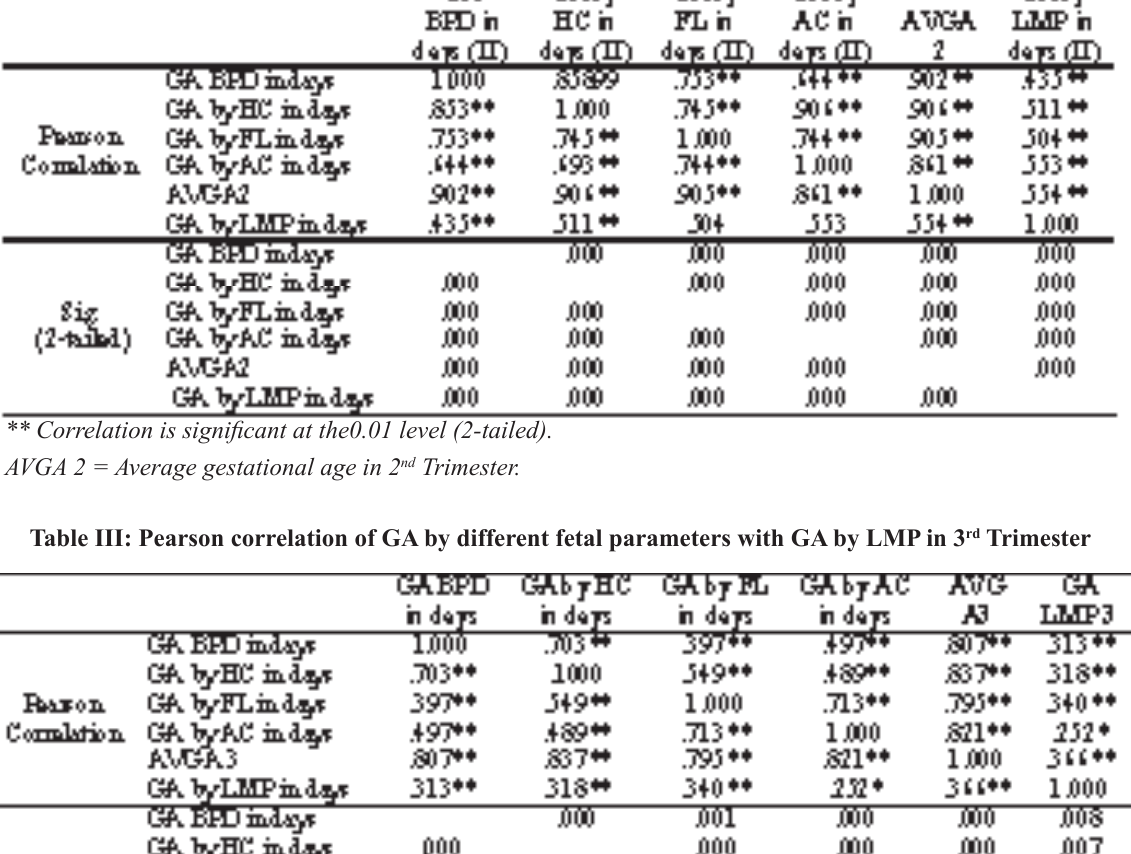
Table II: Pearson correlation of GA by different fetal parameters with GA by LMP in 2 nd Trimester